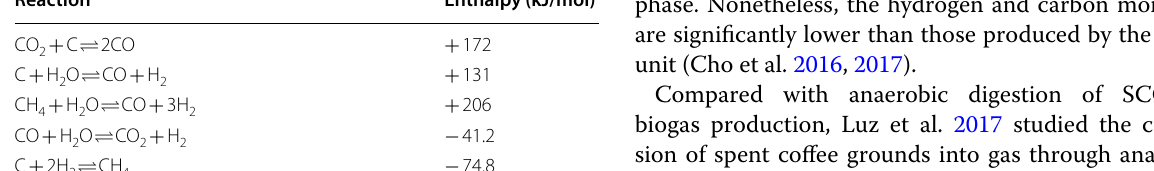
Table 4 Post-reforming reactions (Neumann et al. 2016a) Reaction